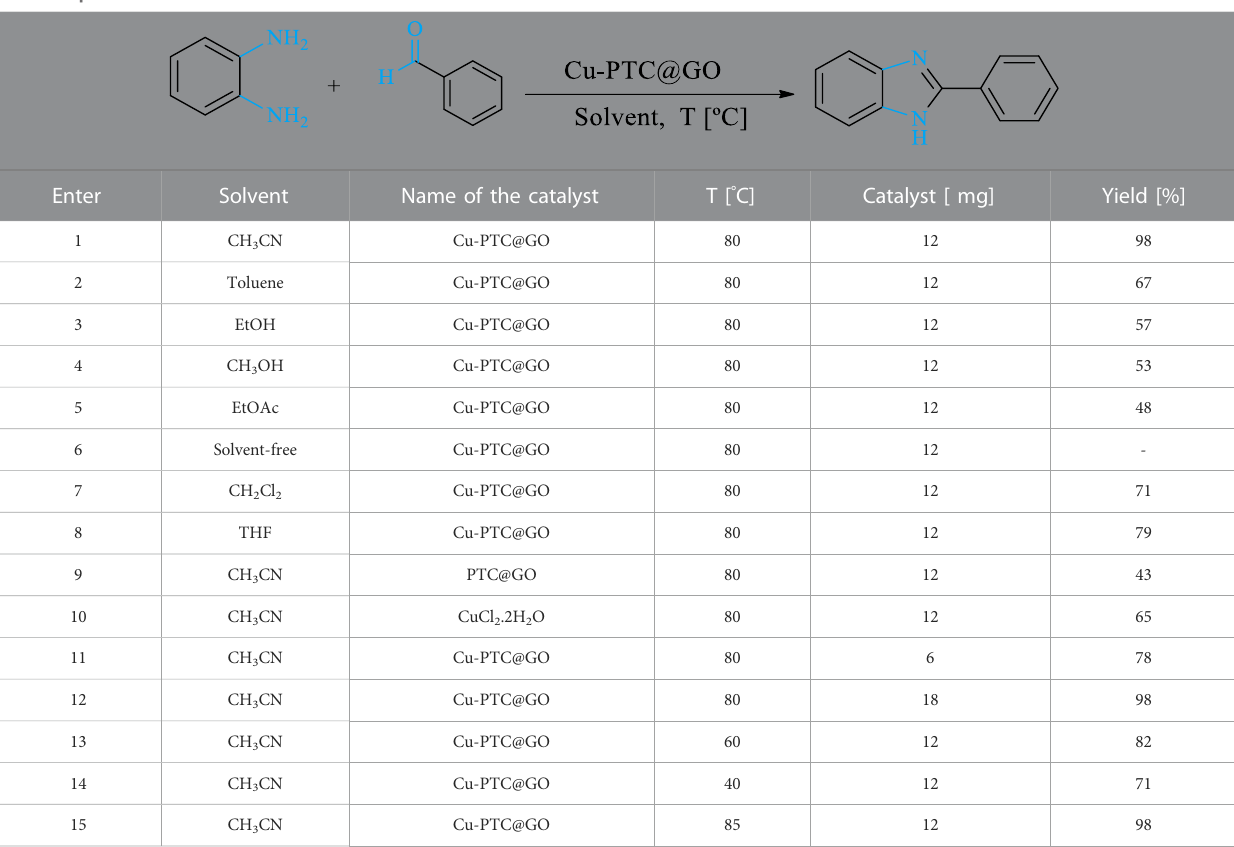
TABLE 1 Optimization of reaction